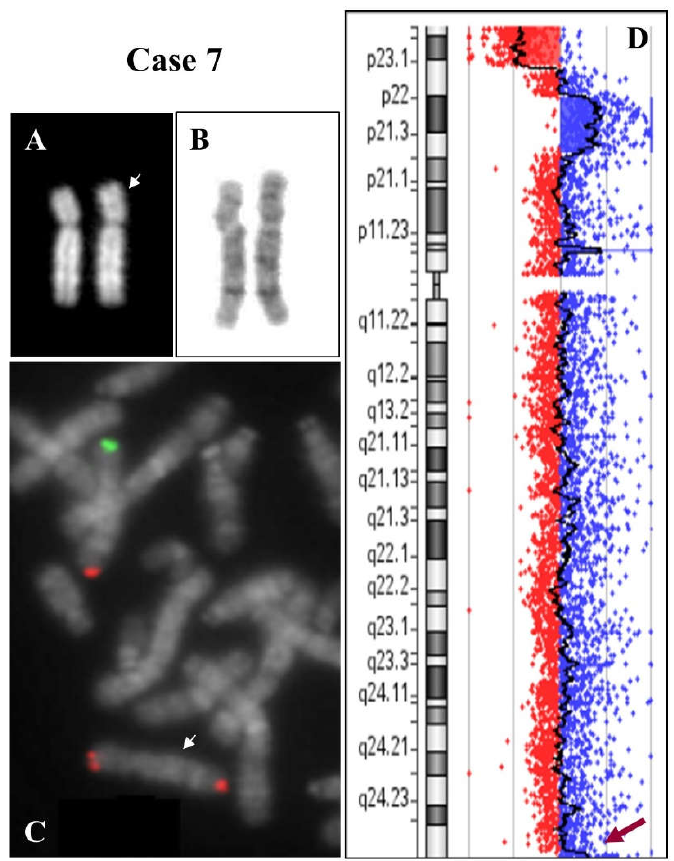
Figure 4. Case 7. ( A ) QFQ-banded chromosome 8 (the white arrow indicates the anomalous chromosome). ( B ) GTG-banded chromosome 8. ( C ) Partial metaphase after FISH with specific subtelomeric probes of chromosome 8 (green: telomere 8p, red: telomere 8q). The anomalous chromosome 8 shows the 8q telomere on both extremities (white arrow). ( D ) Array CGH results. The red arrow indicates a very small duplication of the 8q telomere.